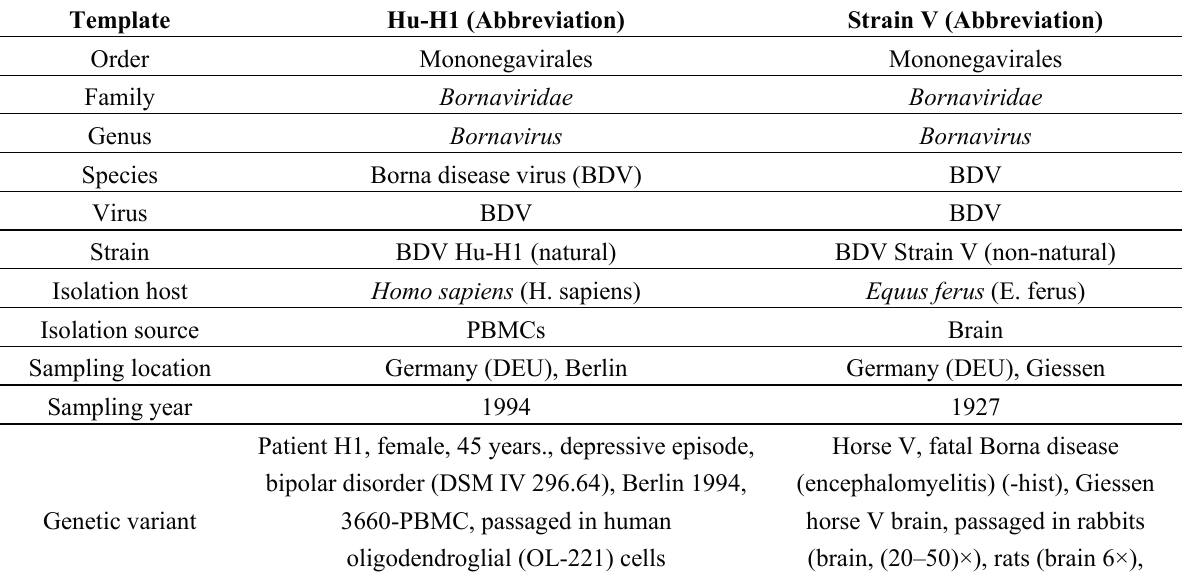
Table 1. Taxonomy and history of Borna disease virus (BDV) strains Hu-H1 and Strain V.